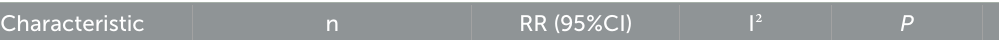
TABLE 3 Subgroup analysis of the effects of PM 10 per 10 µ g/m 3 increment on cardiovascular and respiratory diseases. Characteristic n RR (95%CI) P